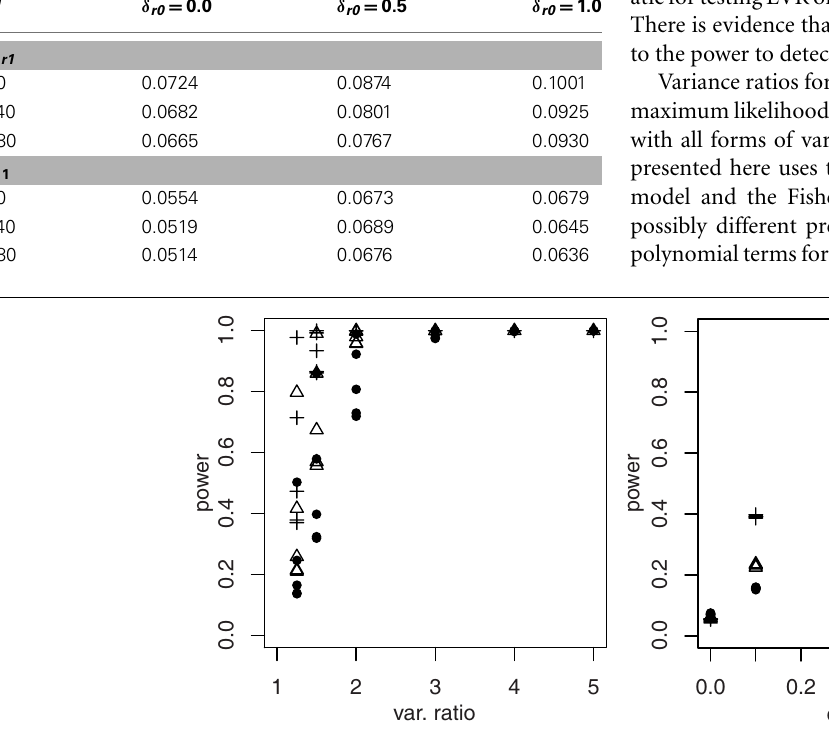
FIGURE 4 | Power for δ r1 and θ r1